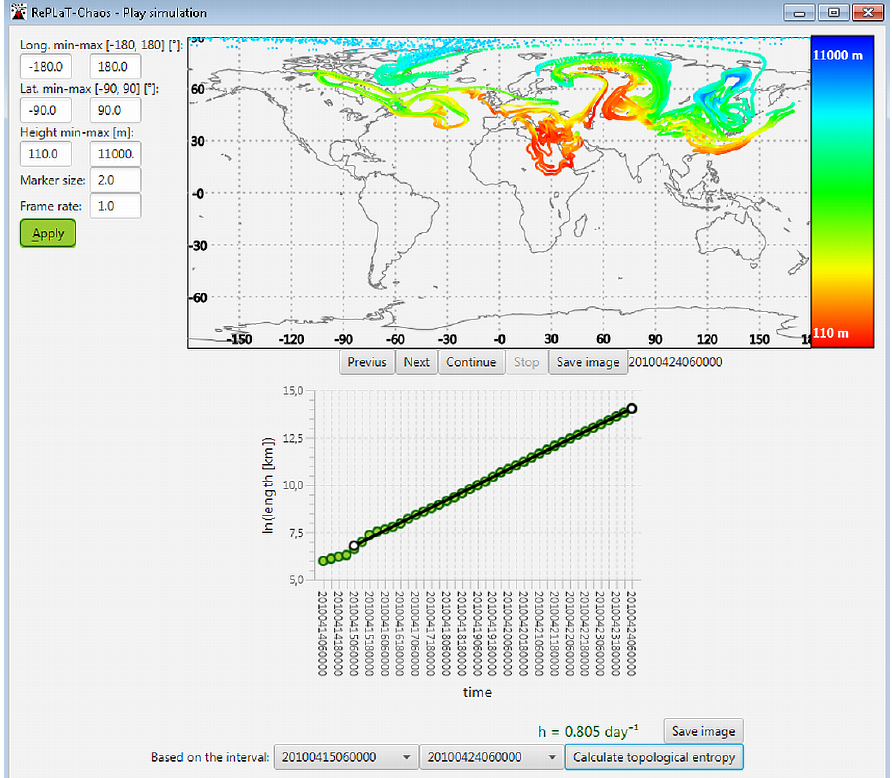
Figure A5. Displaying saved simulation and the time dependence of the length of a pollutant cloud. The simulation is initialized with the simulation parameters on the left of Figure A1 but with top and bottom reflection coefficients of 1 and inserting new particles if the distance of two particles is greater than 100 km. The pollutant cloud is initialized as a meridional line segment of 400 km at 47 ◦ N, 19 ◦ E and at the altitude of 5500 m. It consists of 1000 particles at the beginning. The particle radius is 0 µ